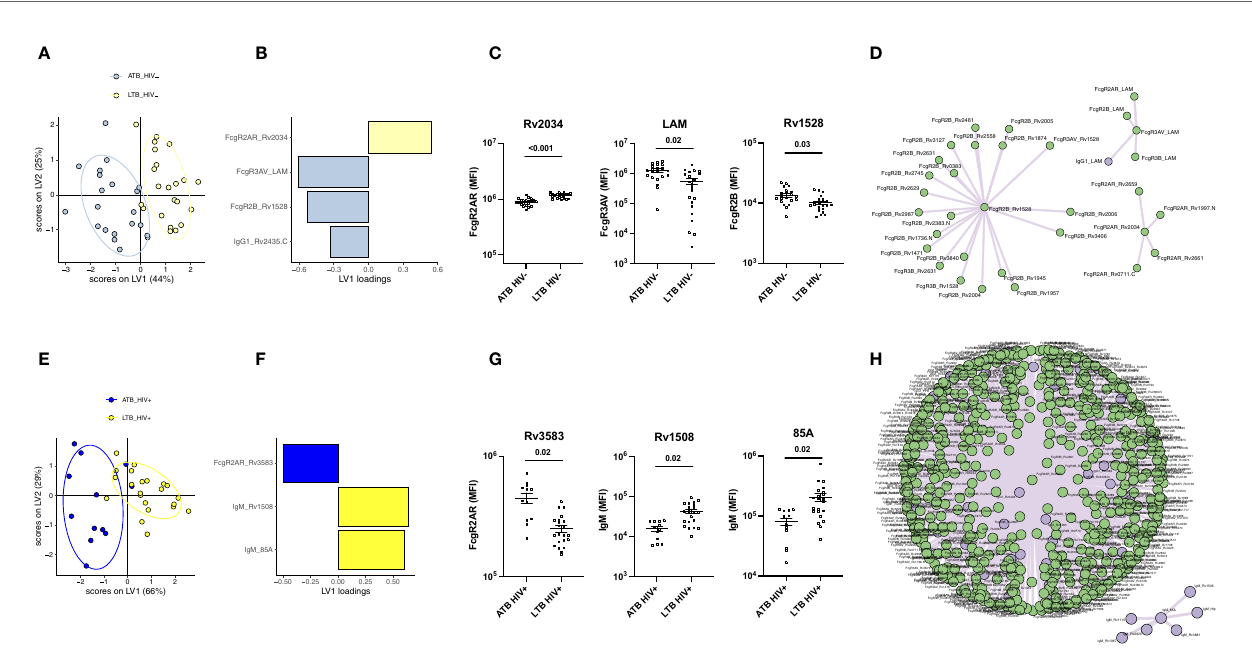
FIGURE 4 | Individuals with ATB and LTB exhibit distinct humoral pro fi le against Mtb antigens regardless of HIV infection. Multivariate analysis comparing antibody response in ATB and LTB among HIV negative (A, B) and HIV positive (E, F) populations. (A, E) PLS-DA models showing dot plots of nearly non-overlapping antibody features in ATB (blue) and LTB (yellow) from HIV negative (A) and positive (E) groups. Ellipses show 95% con fi dence intervals. PLDS-DA models were trained using LASSO-selected features that are plotted on VIP plots for HIV negative (B) and positive (F) patients. Cross-validation accuracy for (A, E) was 74.2% and 79.1%, respectively. Antibody features showing signi fi cant differences between ATB and LTB are graphed for the HIV negative (C) and HIV positive (G) cohorts. A Mann-Whitney U-test test followed by a Benjamini-Hochberg (BH) correction for multiple comparisons was used to test for statistically signi fi cant differences ATB and LTB. Network correlations depicting the additional non-LASSO-selected features that were correlated with the LASSO-selected parameters statistically different between ATB and LTB in the HIV negative (D) and positive (H) groups. Data on antibody levels are in purple, features related to Fc g R binding are in